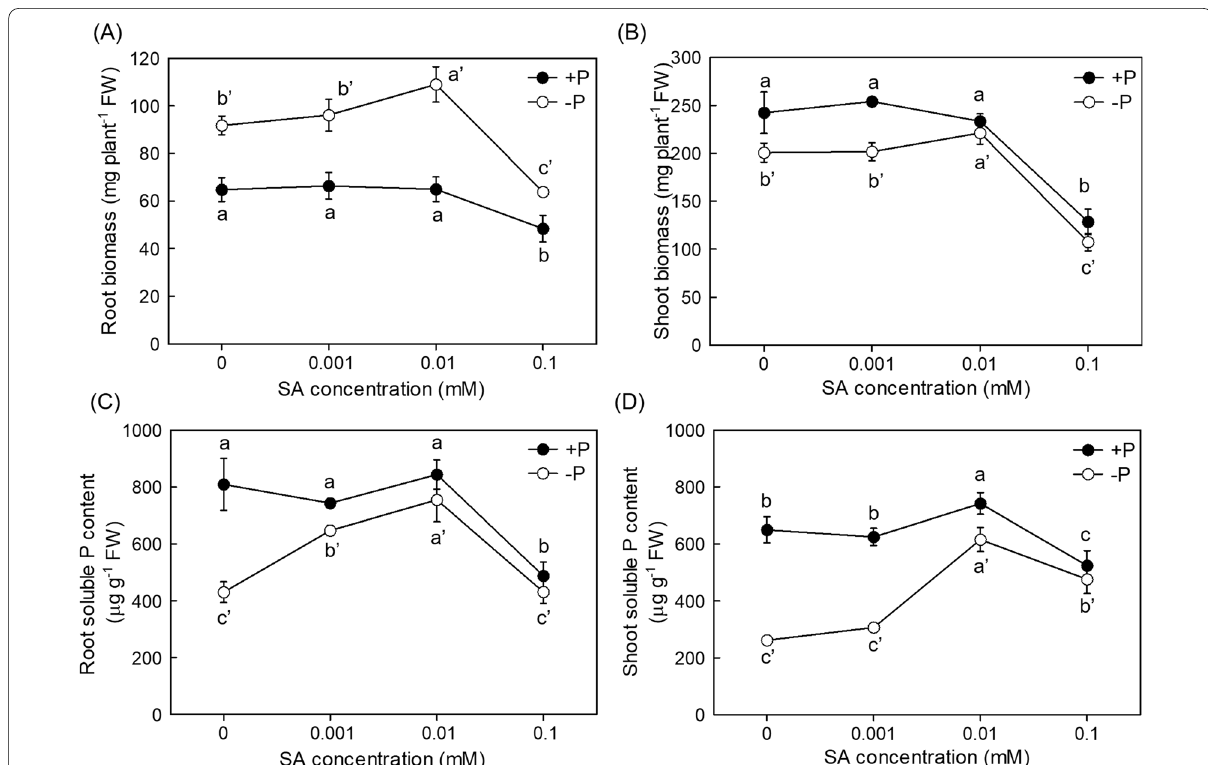
Fig. 2 The effect of different concentrations of SA on the plant growth under P deficient condition in rice. Root and shoot biomass ( A and B ) and soluble P content ( C and D ) in Nip were measured. Data are means multiple range test at the P <